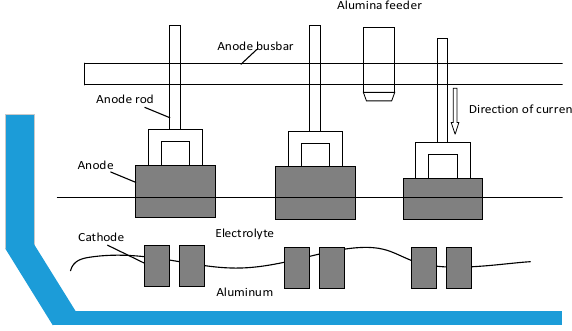
Figure 6. Internal structure of a typical reduction cell.